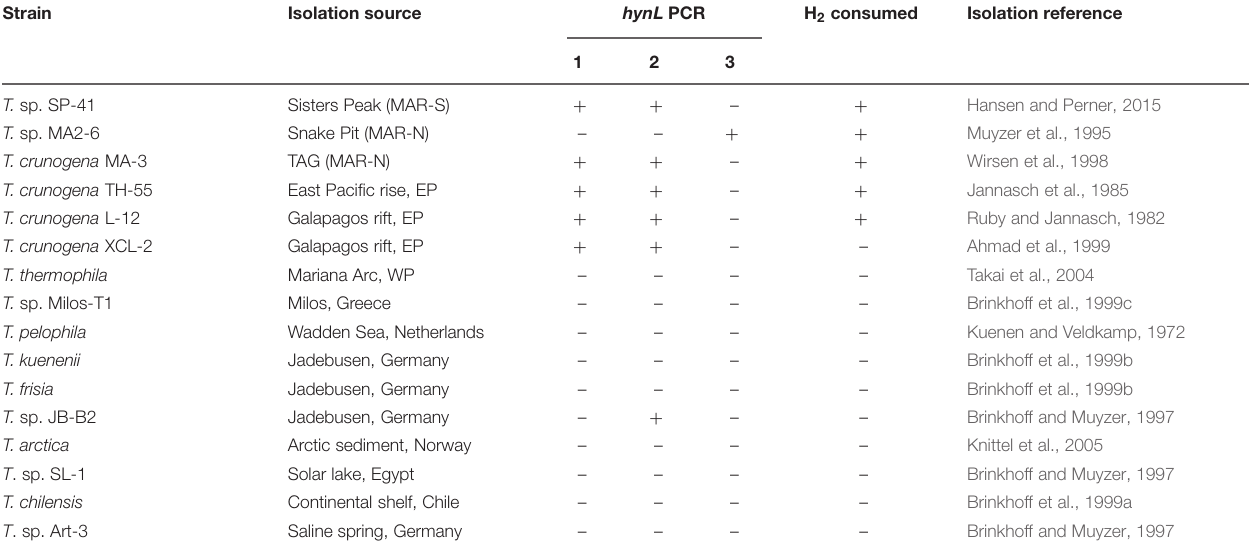
TABLE 2 | Strains investigated in this study and hynL gene amplification results.